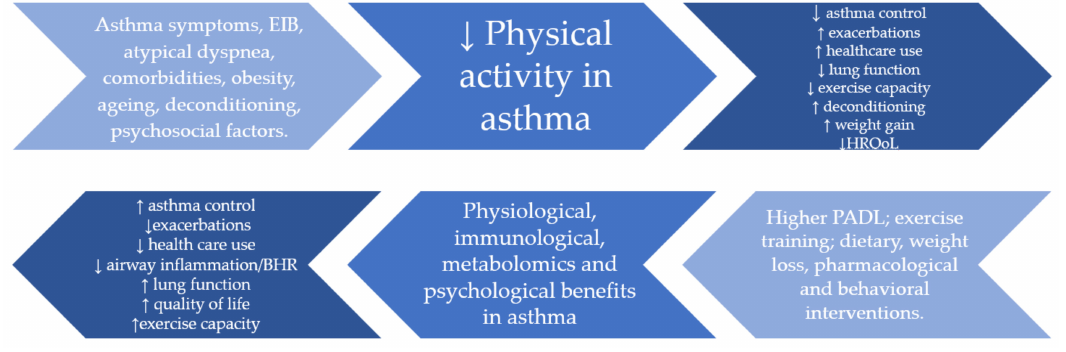
Figure 1. Conceptual model for the interrelationship between asthma, physical activity and targeted interventions. EIB: exercise-induced bronchoconstriction; PADL: physical activity in daily life; BHR: bronchial